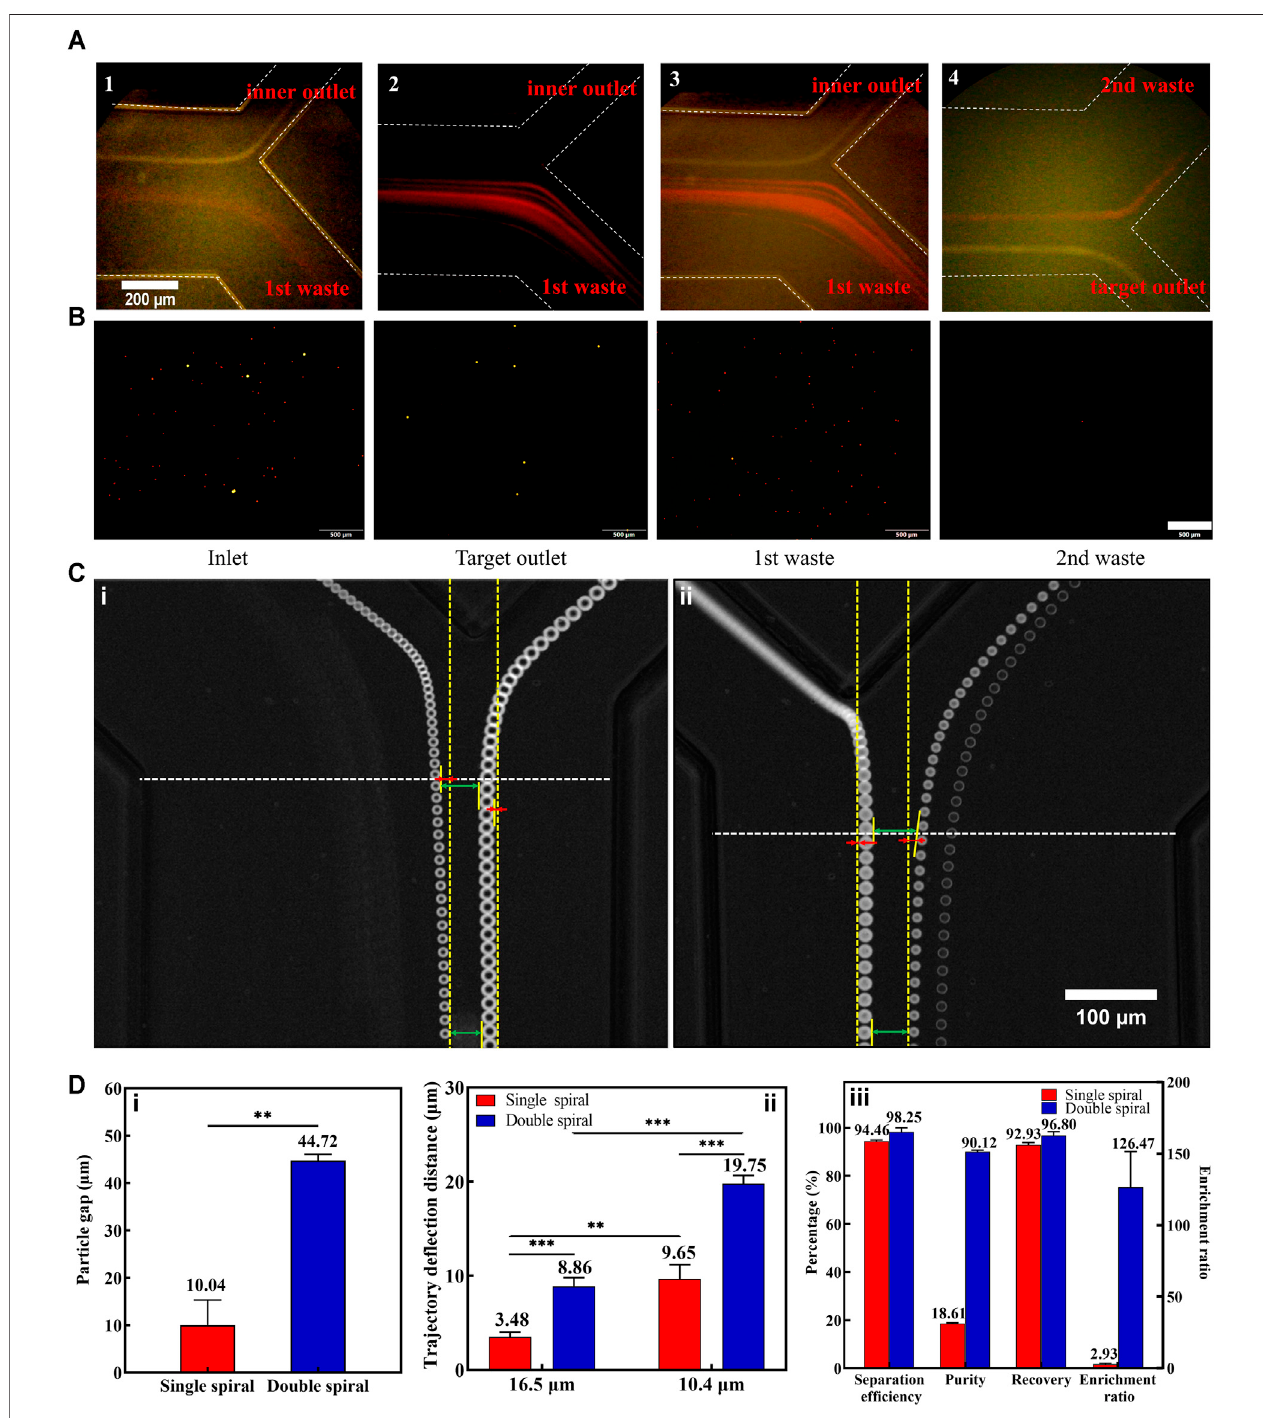
FIGURE 3 | Results of fl uorescent microspheres for separation. (A) The captured fl uorescent trajectories of 16.5 μ m (1) and 10.4 μ m (2) at the fi rst bifurcation. Composite images at the fi rst (3) and second (4) bifurcation. The whitedotted lines indicate the microchannel walls. (B) Microspheres (16.5 μ m with yellow fl uorescence and10.4 μ mwithred fl uorescence)collectedattheinletanddifferentoutlets.Thescalebaris500 μ m. (C) Therepresentativesuperimposedimagesof16.5and10.4 μ m microspheresatthe fi rstbifurcationofboth single (i) anddouble (ii) spiralmicrochannels.Somemeasurement reference linesweremarkedinthepanel. (D)(i) :The particle gaps between 16.5 and 10.4 μ m microspheres in single and double spiral microchannels. (ii) : The particle trajectory de fl ection distances in single and double spiral microchannels. (iii) : Comparative results of methodological parameters between single and double spiral microchannels. ** p < 0.05, *** p < 0.001.